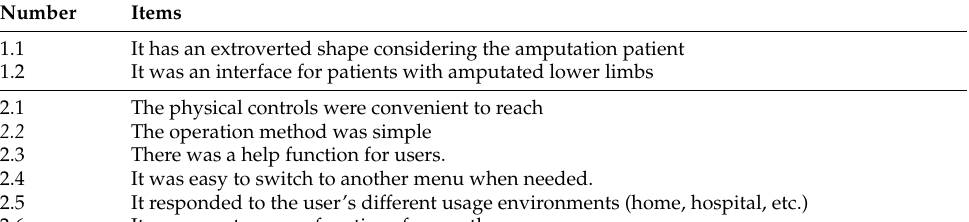
Table 5. Items of Usability Test.